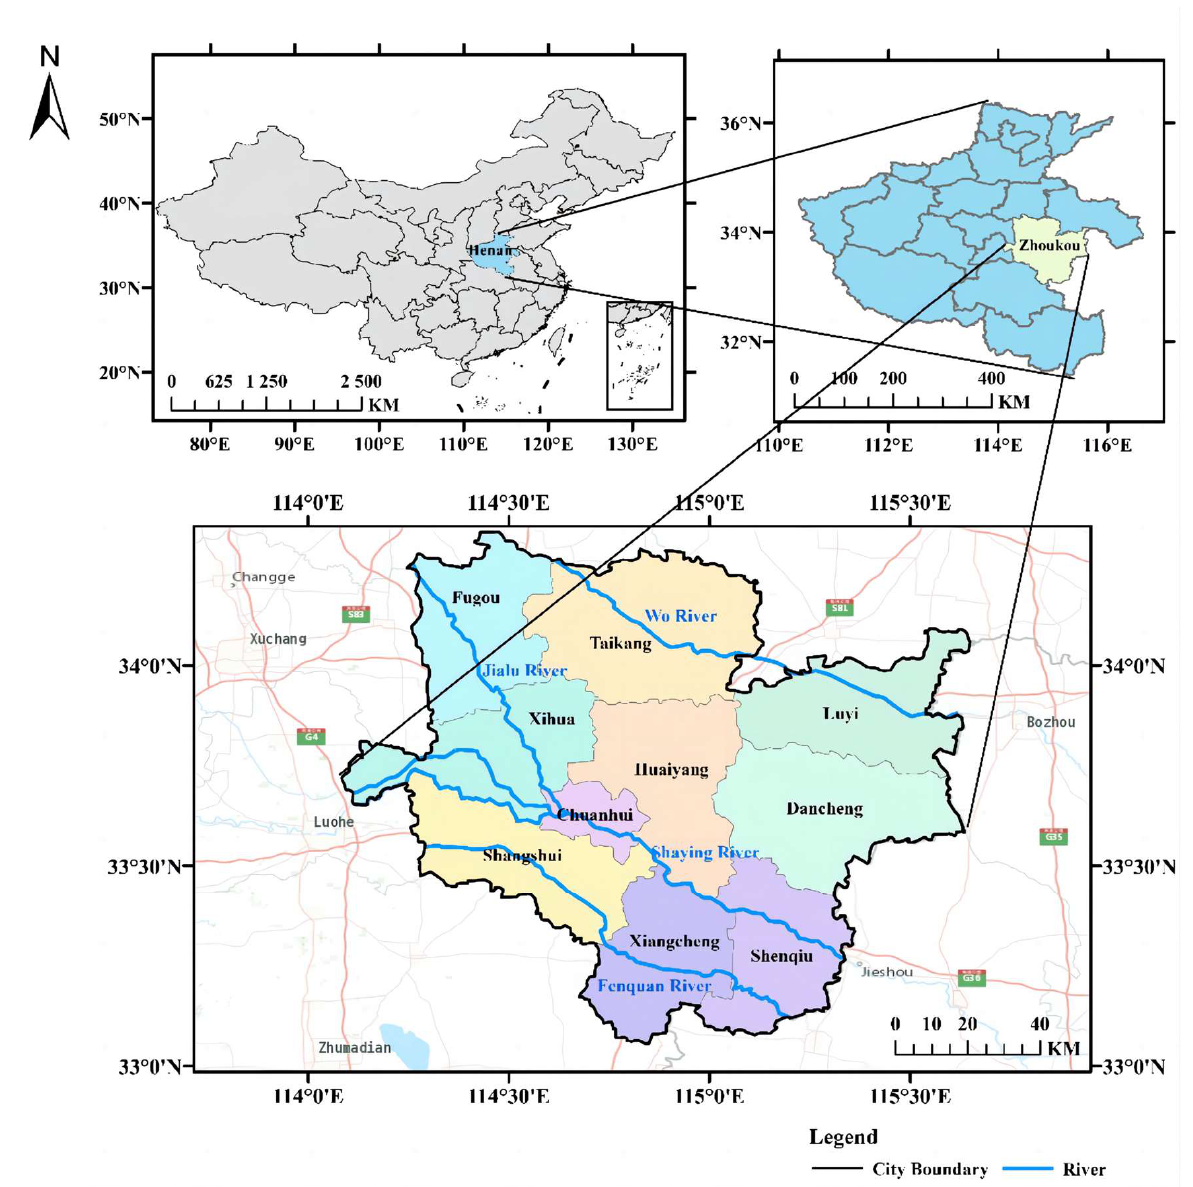
Figure 1. Zhoukou city location map.